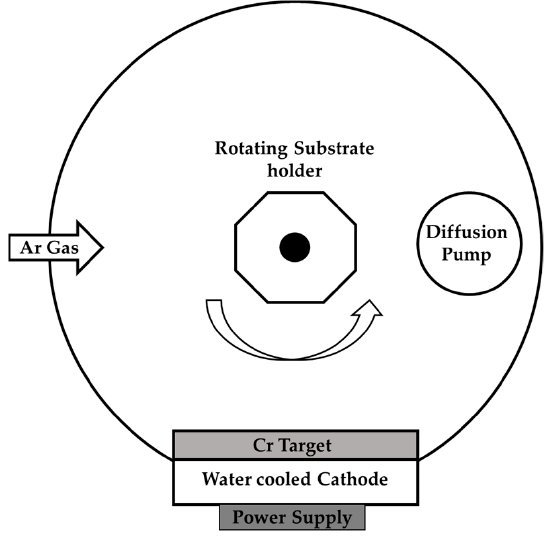
Figure 1. Schematic diagram of the magnetron sputtering deposition chamber.